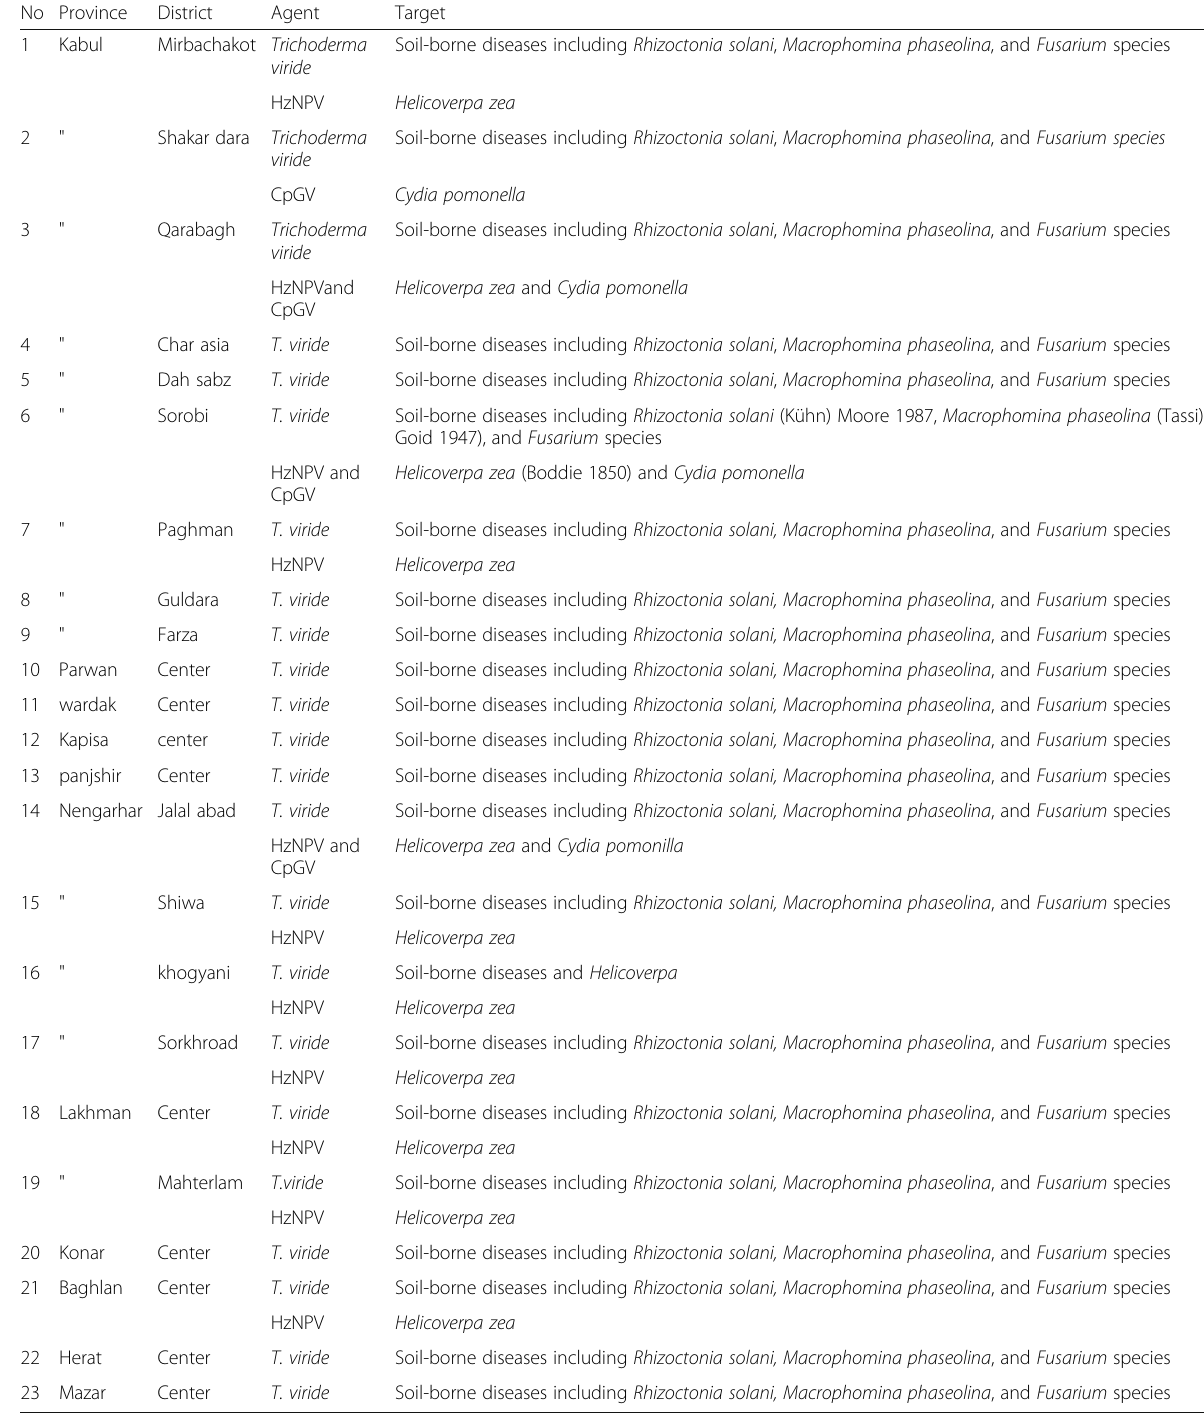
Table 1 Available biological agents reported by the National Horticulture and Livestock Project for use in Afghanistan (NHLP Report